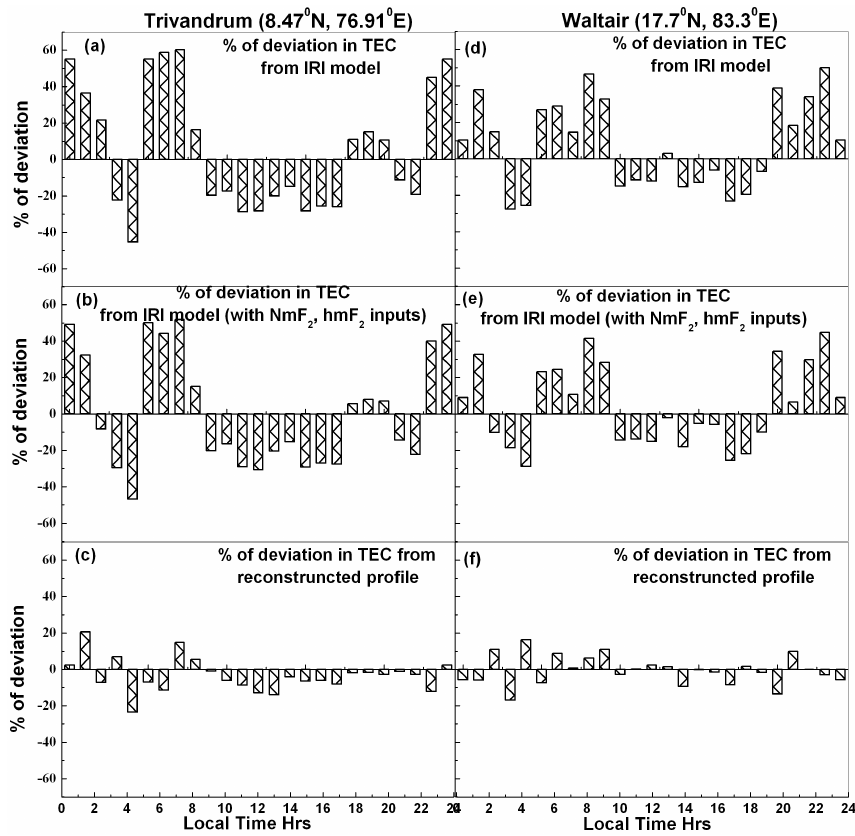
Fig. 7. Percentage deviations of IRI (2007) model derived TEC and reconstructed profile derived TEC from GPS measured TEC over Trivandrum ( a , b and c ) Percentage deviations of IRI (2007) model derived TEC and reconstructed profile derived TEC from GPS measured TEC over Waltair ( d , e and f